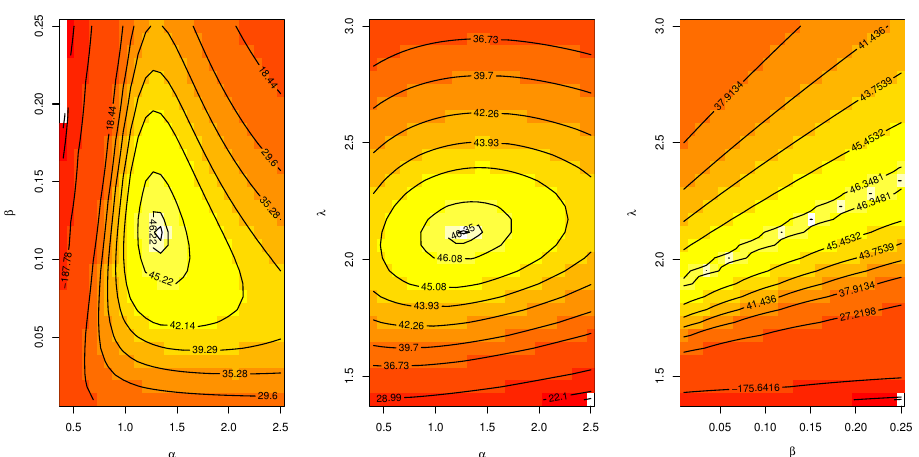
Figure 5. Contour plot of UEP for the recovery rate of COVID-19 data from Turkey.